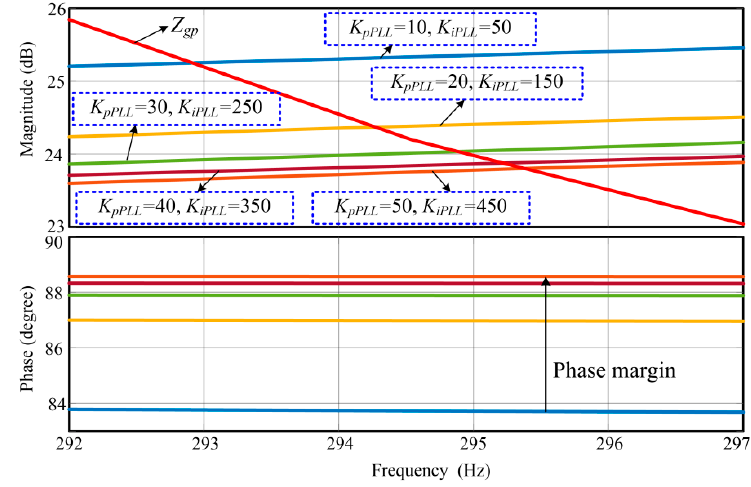
Figure 11. Bode plot of DFIG impedance and parallel compensated weak grid with different PLL parameters.